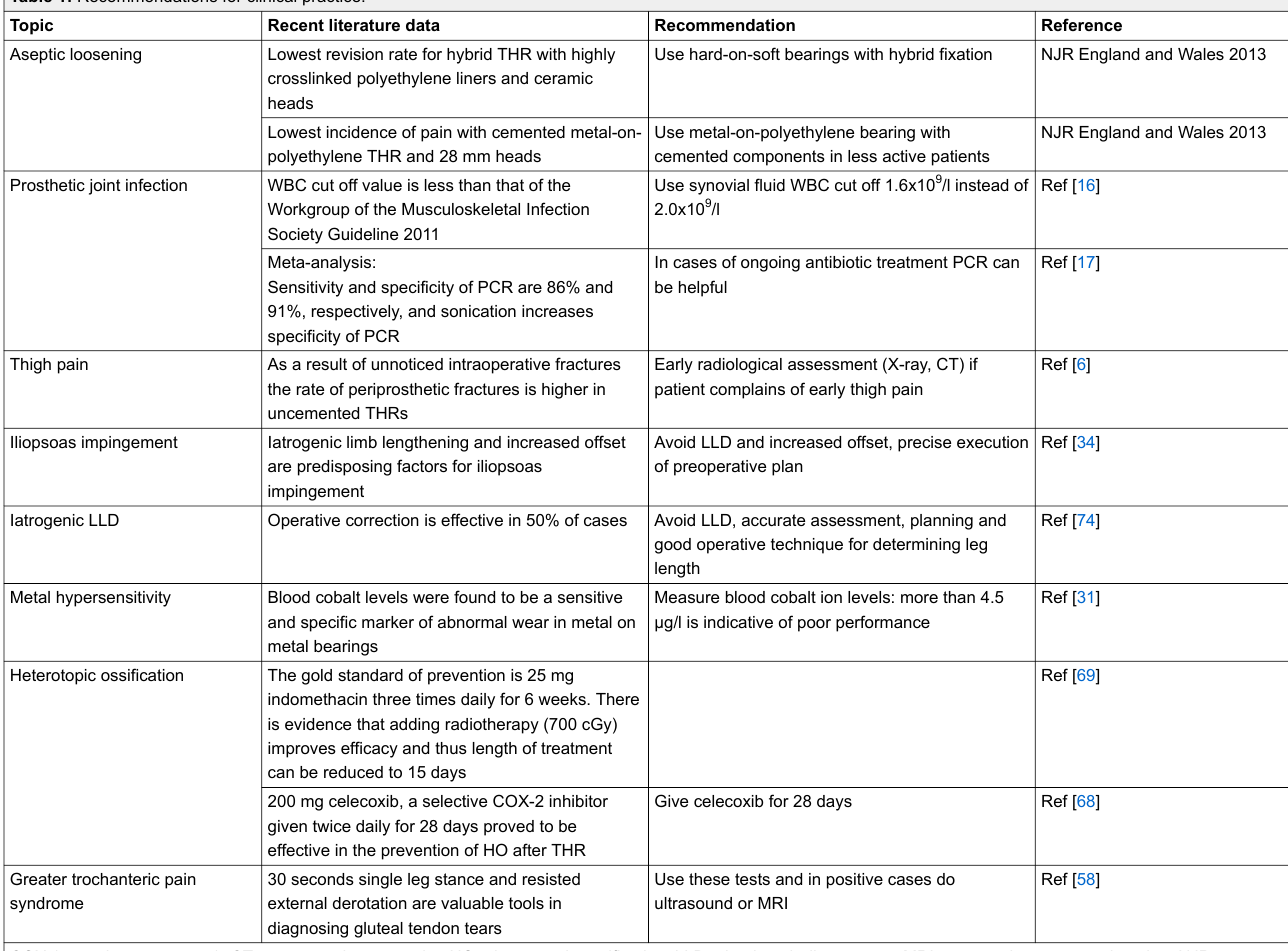
Table 1: Recommendations for clinical